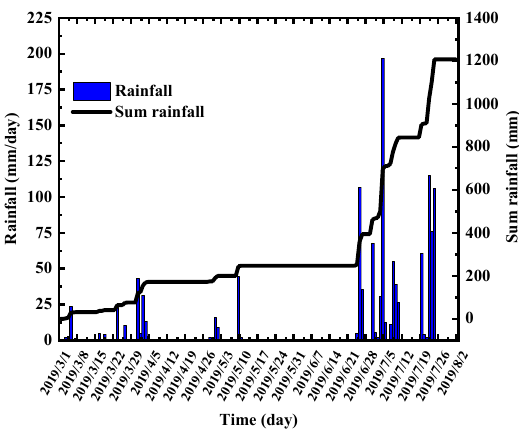
Figure 4. Daily rainfall from 1 March to 2 August 2019 (155 days in total).